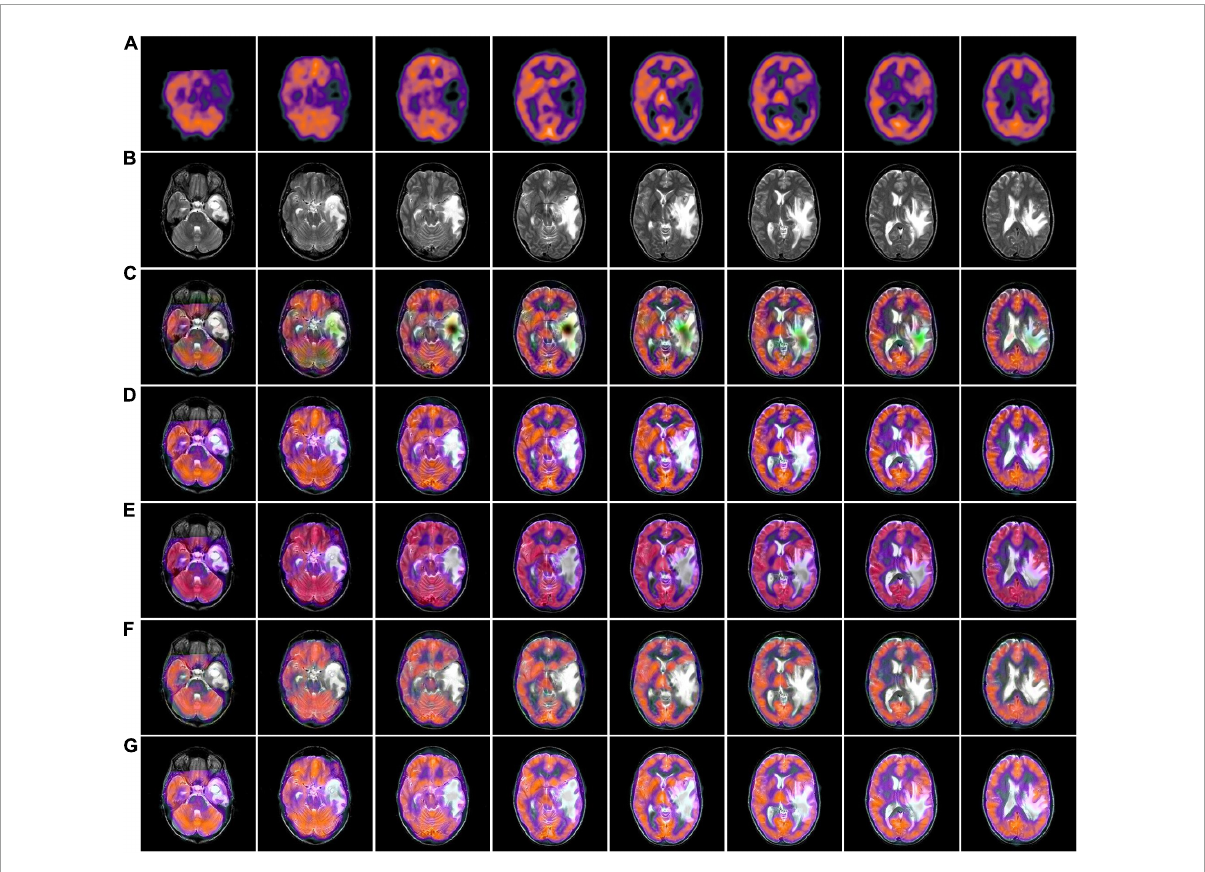
FIGURE7 MRI-SPECT fusion images of the five methods in Paras2. (A) Single photon emission computed tomography (SPECT) source image; (B) magnetic resonance imaging (MRI) source image; (C) nonsubsampled contourlet (NSCT) fusion result; (D) non-subsampled shear wave transform (NSST) fusion result; (E) guided filter ng fusion (GFF) fusion result; (F) Laplacian redecomposition (ReLP) fusion result; (G) fusion result of the proposed method.